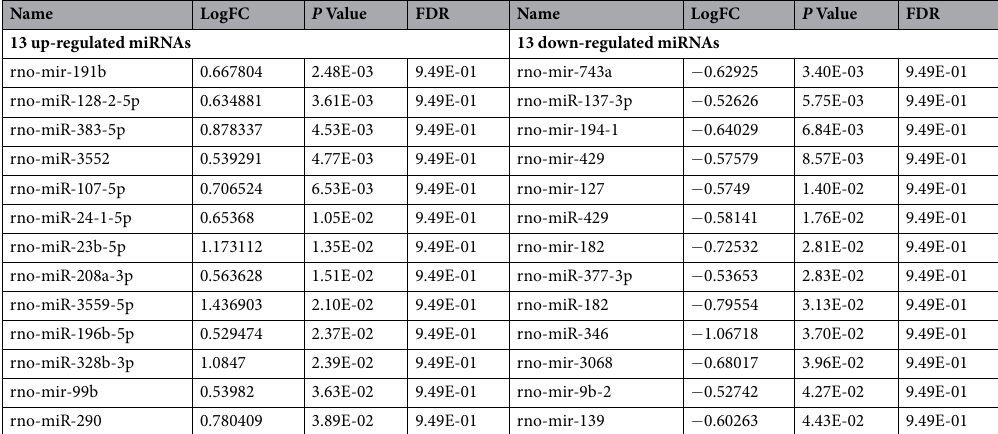
Table 2. Top 50 differentially expressed miRNAs in CI samples, half up-regulated, half